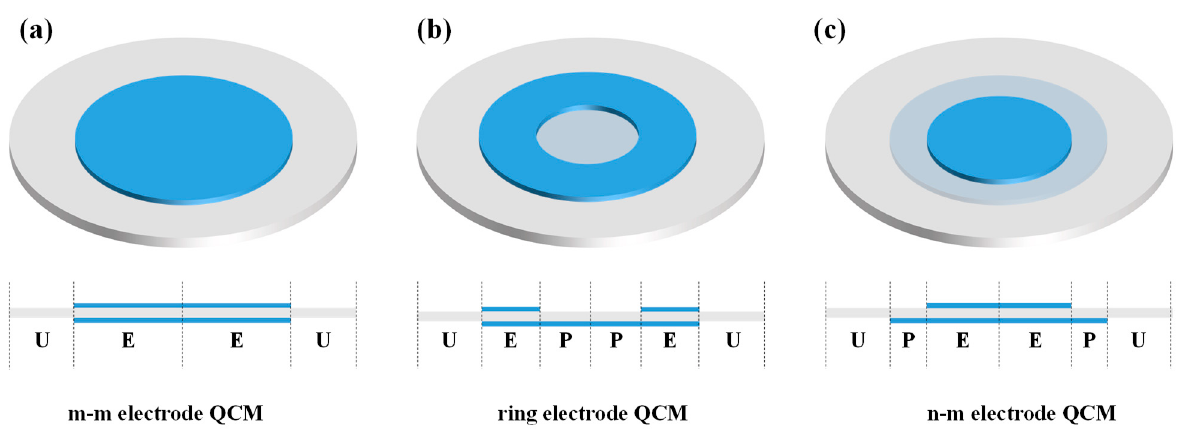
Figure 1. Schematic diagram of the structure of the ( a ) m-m electrode QCM, ( b ) ring electrode QCM, and ( c ) n-m electrode QCM. E, P, and U represent the electroded region, partially electroded region, and unelectroded region, respectively.